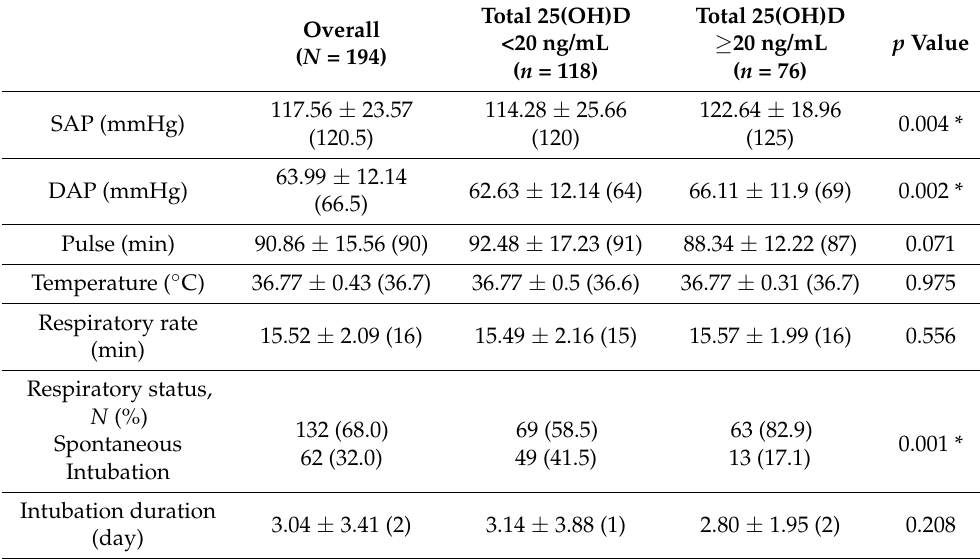
Table 2. Comparison of clinical and vital findings of COVID-19 patients according to the vitamin D